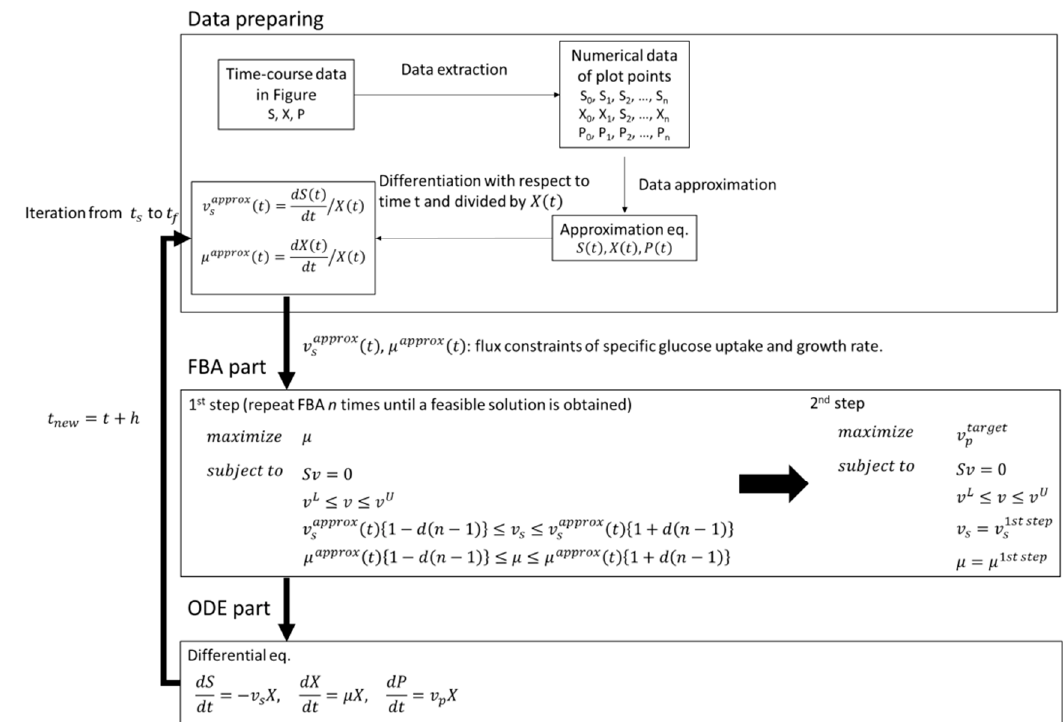
Figure 6. Workflow of methodology from time-course data in figure to dynamic flux balance analysis. Under the section Data preparing, S, X, and P indicate substrate, cell, and product, respectively. Subscripts (0, 1, …, n) show sampling points. S(t) , X(t) , and P(t) represent approximate equation of substrate, cell, and product, respectively. v s approx (t) , μ approx (t) represent the approximated specific substrate uptake and growth rates, respectively. t s , t f , and h indicate start time, finish time, and time step for calculation, respectively. In the section FBA, S : stoichiometric matrix; v : flux vector; d : the arbitrary constant for changing boundary; n : n th repetition; superscript L : lower boundary; U : upper boundary; target: target product.